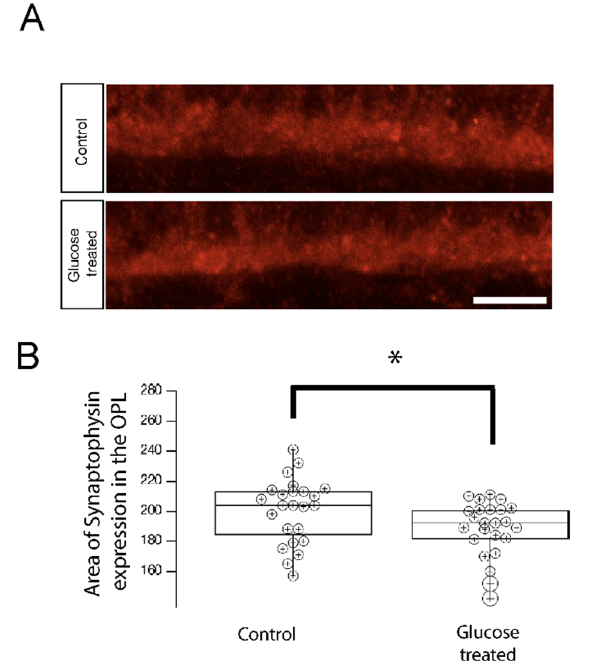
Figure 7. Synaptophysin accumulation in the OPL is reduced in 5 dpf hyperglycemic larvae. ( A ) Transverse retinal sections from 5 dpf control and hypoglycemic larvae were immunostained with fluorescently labeled antibodies specific for the synaptic vesicle marker synaptophysin. Maximal intensity projections are shown. Scale bar, 5 µ m. Synaptophysin accumulation was reduced in hyperglycemic larvae relative to that in control larvae. ( B ) Quantitative analyses of IHC for synaptophysin accumulation in control and hyperglycemic larvae are indicated by box-and-whisker plots. Boxes indicate median value ranges, while whiskers indicate 5th–95th percentile values. Data represent the average value of the area of expression in 6–9 animals obtained from 3–5 independent experiments we sampled per condition, shown as individual data points. Scale bar, 5 μ m. * p < 0.05; two-tailed t -test. Abbreviations used: dpf, days post-fertilization; SEM, standard error of the mean.